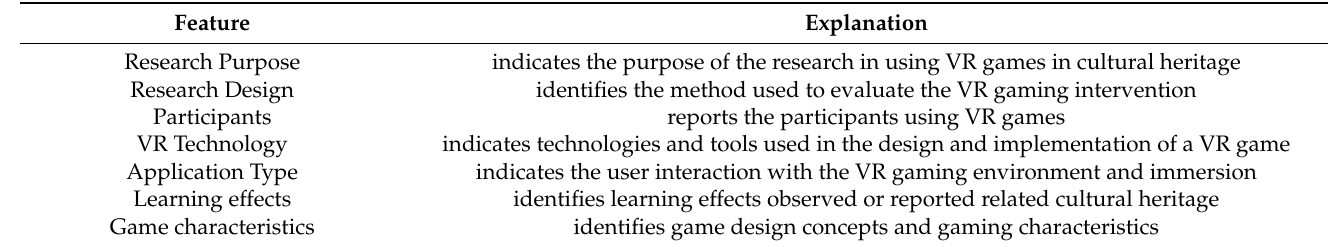
Table 3. Data extraction—coding scheme.